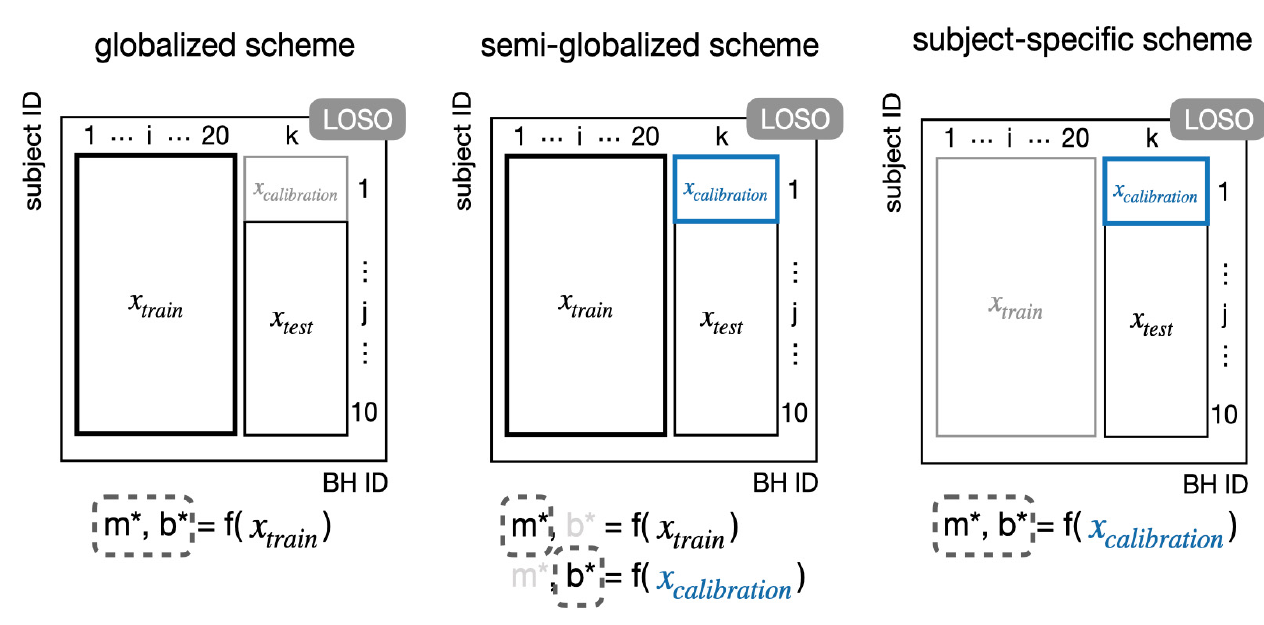
Figure 5. Different model training schemes, where x train denotes the data from the training subjects; x calibration denotes the first breath-hold data from the test subject; x test denotes the data of the test subject excluding the first breath-hold; k denotes the left-out subject. The parameters used to construct the model are in the dashed boxes. Data or parameters not used at all were colored in light gray. ( a ) Globalized scheme (no subject-specific calibration). ( b ) Semi-globalized scheme (with subject-specific calibration). ( c ) Subject-specific